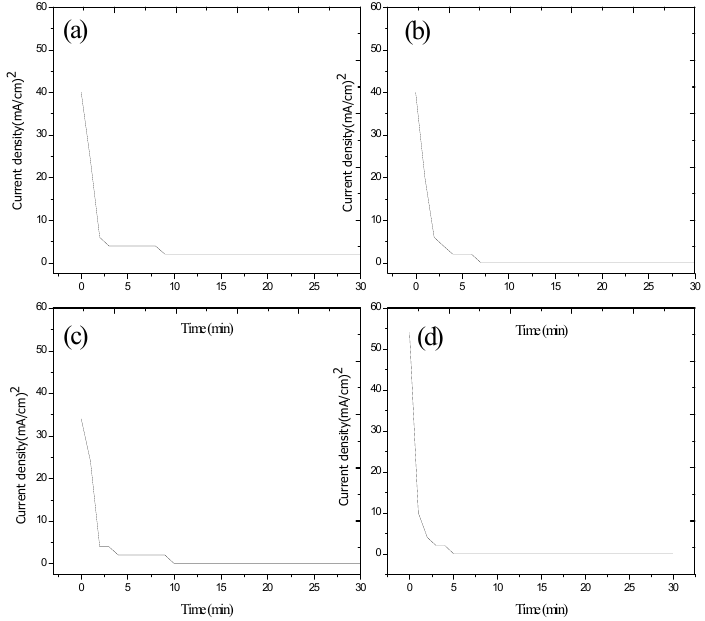
Figure 4. Current ‐ density time response of CuTiO 2 NTs samples anodized using different Cu ‐ loadings Figure 4. Current-density time response of CuTiO 2 NTs samples anodized using different Cu-loadings in EG ‐ electrolytes labelled ( a ) Cu ‐ 01; ( b ) Cu ‐ 02; ( c ) Cu ‐ 03; ( d ) Cu ‐ 04. in EG- electrolytes labelled ( a ) Cu-01; ( b ) Cu-02; ( c ) Cu-03; ( d )